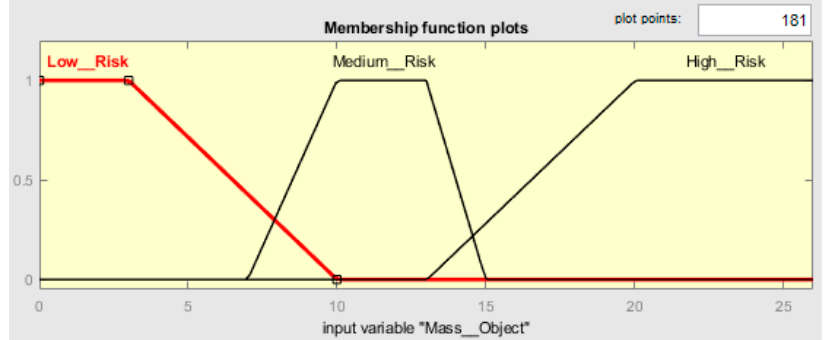
Figure 5. Membership function plots of Mass_Object. Table 6. Ranges of the mass of the object and their fuzzy sets. Variable Fuzzy Set kg